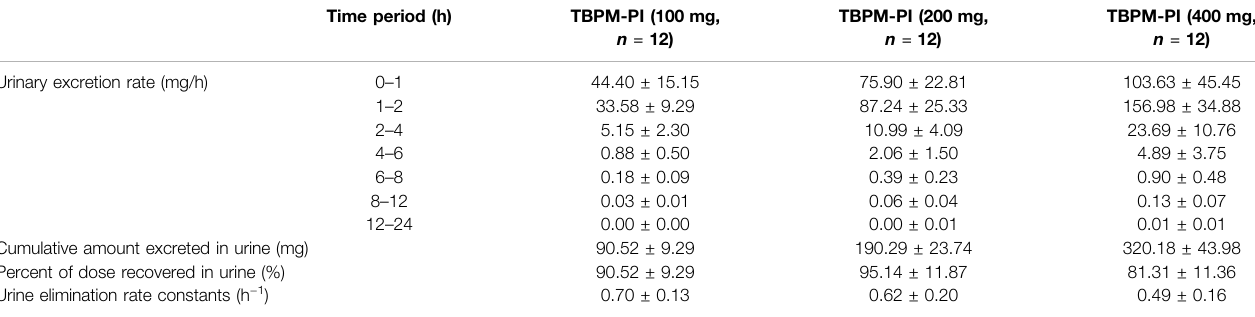
TABLE 3 | Urinary excretion parameter of TBPM after oral administration at dosage of 100, 200, and 400 mg.